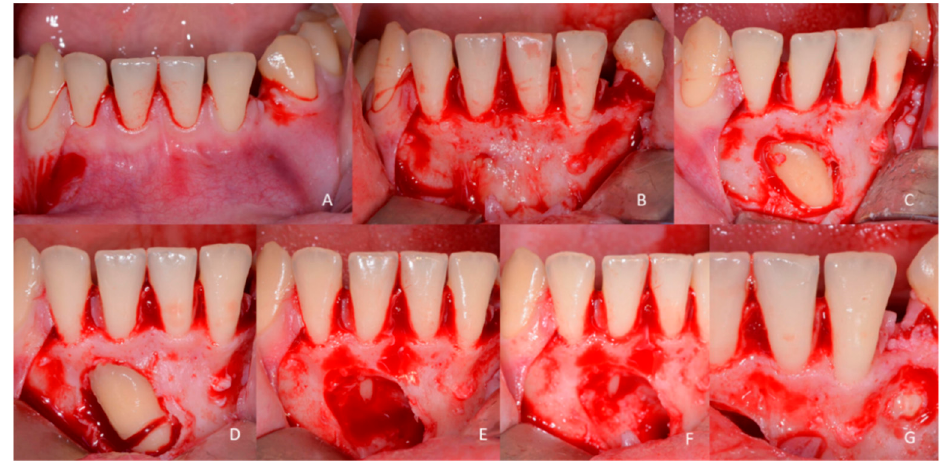
Figure 11. Intraoral photographic documentation before surgery. ( A ) Frontal view; ( B ) Particular of the frontal view in correspondence of the impacted canine upper area.